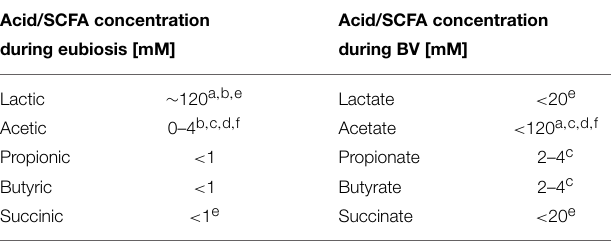
TABLE 3 | Shifts in CVF metabolite concentration in eubiosis compared to the CVF of women with BV. Acid/SCFA